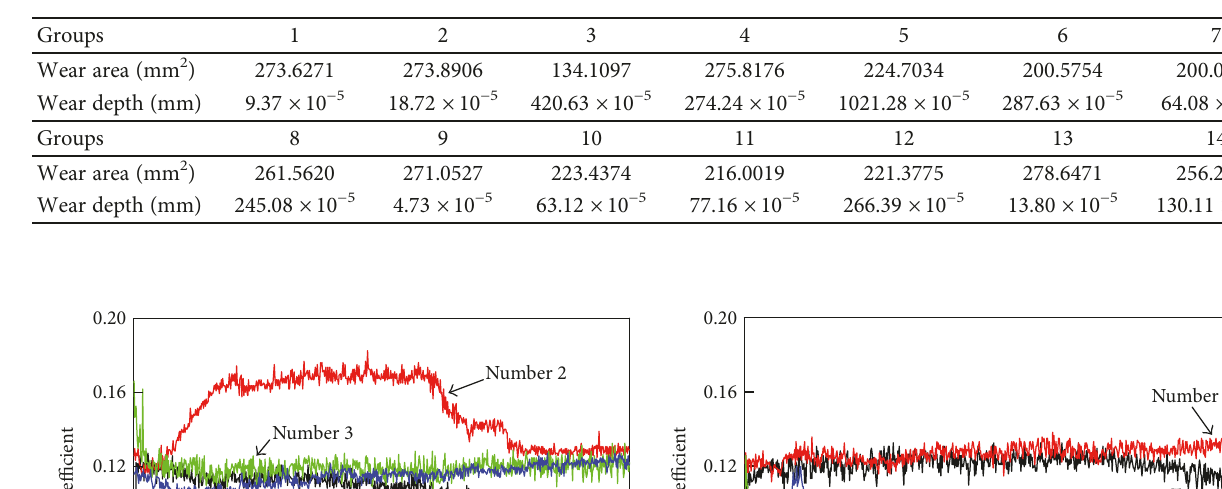
Table 6: Wear depth.